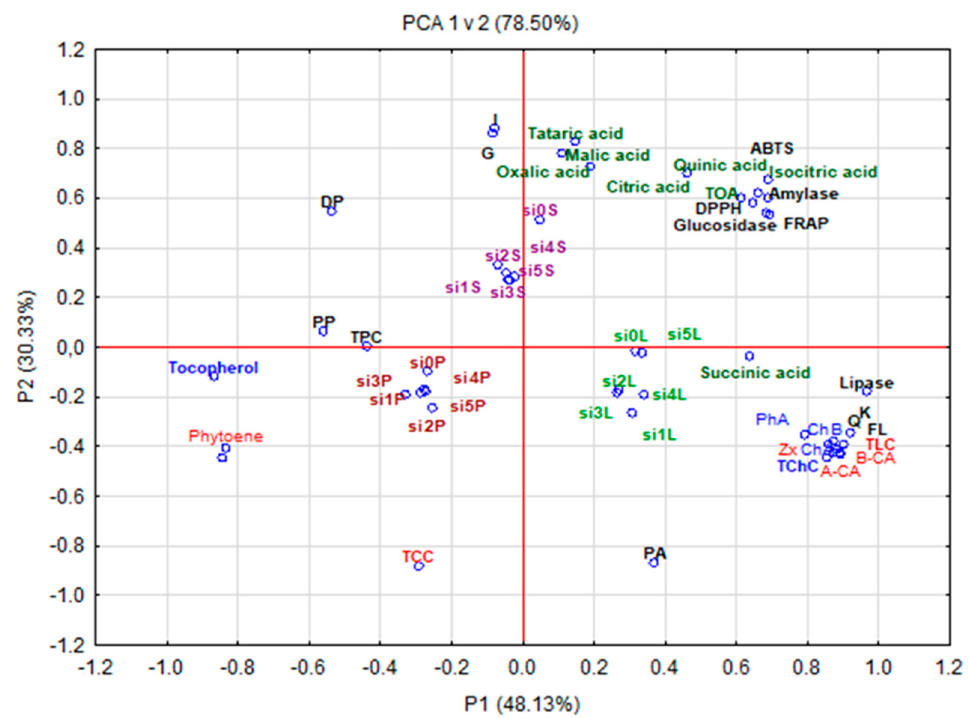
Figure 3. PCA map showing the relationship among chemical composition and biological activities of 6 new biotypes in the peel, seeds, and leaves of cherry silverberry. Explanation: si0P-si5P, the fruit skin + pulp; si0S-si5S, the seeds; si0L-si5L, the leaves; I, isorhamnetin; G, hydrolysable tannin; K, kaempferol; Q, quercetin; FL, sum of flavonoids; PP, polymeric procyanidins; DP, degree of polymerization; TPC, sum of polyphenols; PA; sum of phenolic acids; TCC; sum of carotenoids; TLC, sum of lycopene; A-CA, α -carotene; B-CA, β -carotene; Zx, zeaxanthin; ChB, chlorophyll b; ChA, chlorophyll a; TChC; sum of chlorophylls.